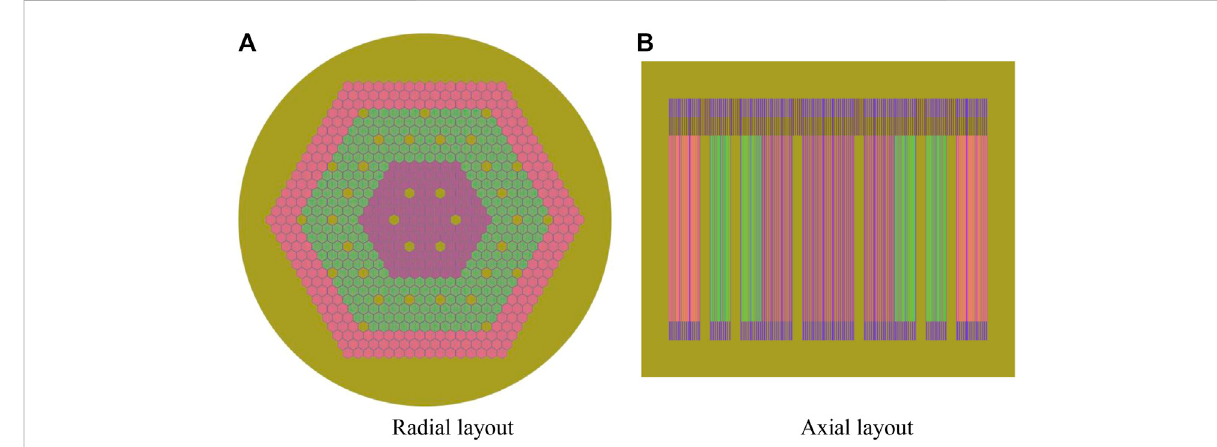
FIGURE 4 500-MWt core arrangement diagrams of UO 2 and U-10Zr: (A) radial layout and (B) axial layout.